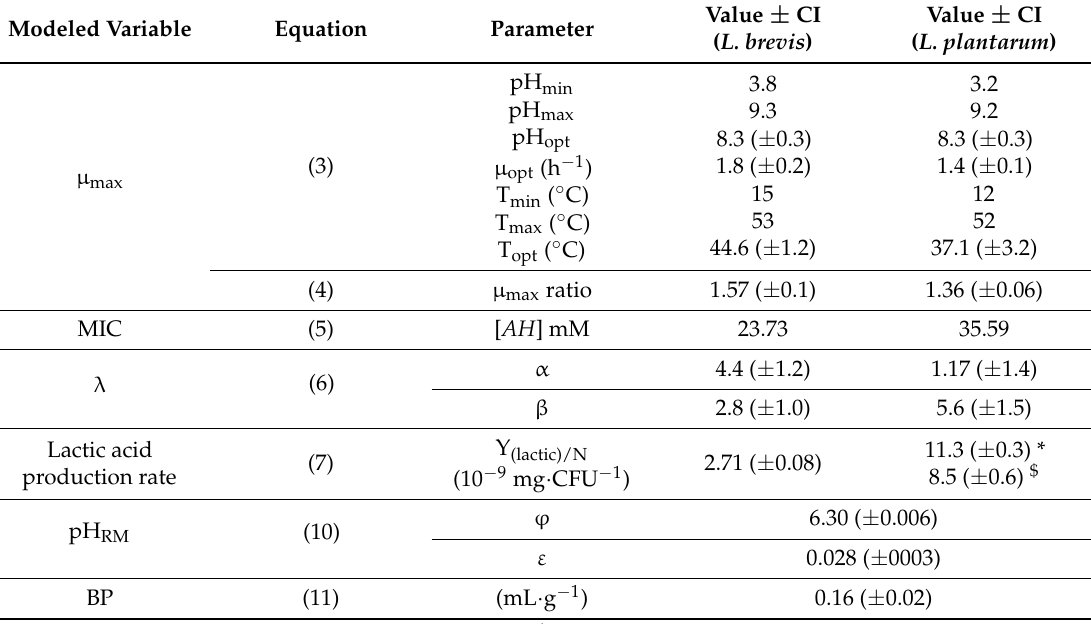
Table 1 . Parameters of the models of μ max, lactic acid production rate and pH. CI = confidence Table 1. Parameters of the models of µ max, lactic acid production rate and pH. CI = confidence intervals ( α = 0.05). intervals ( α =